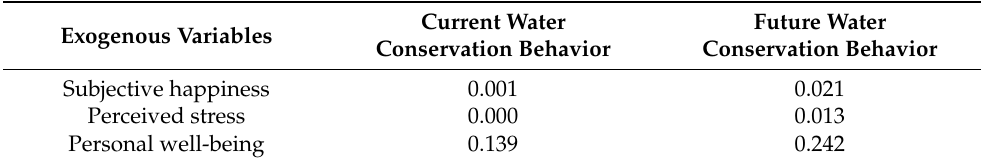
Table 5. Effect Size (f 2